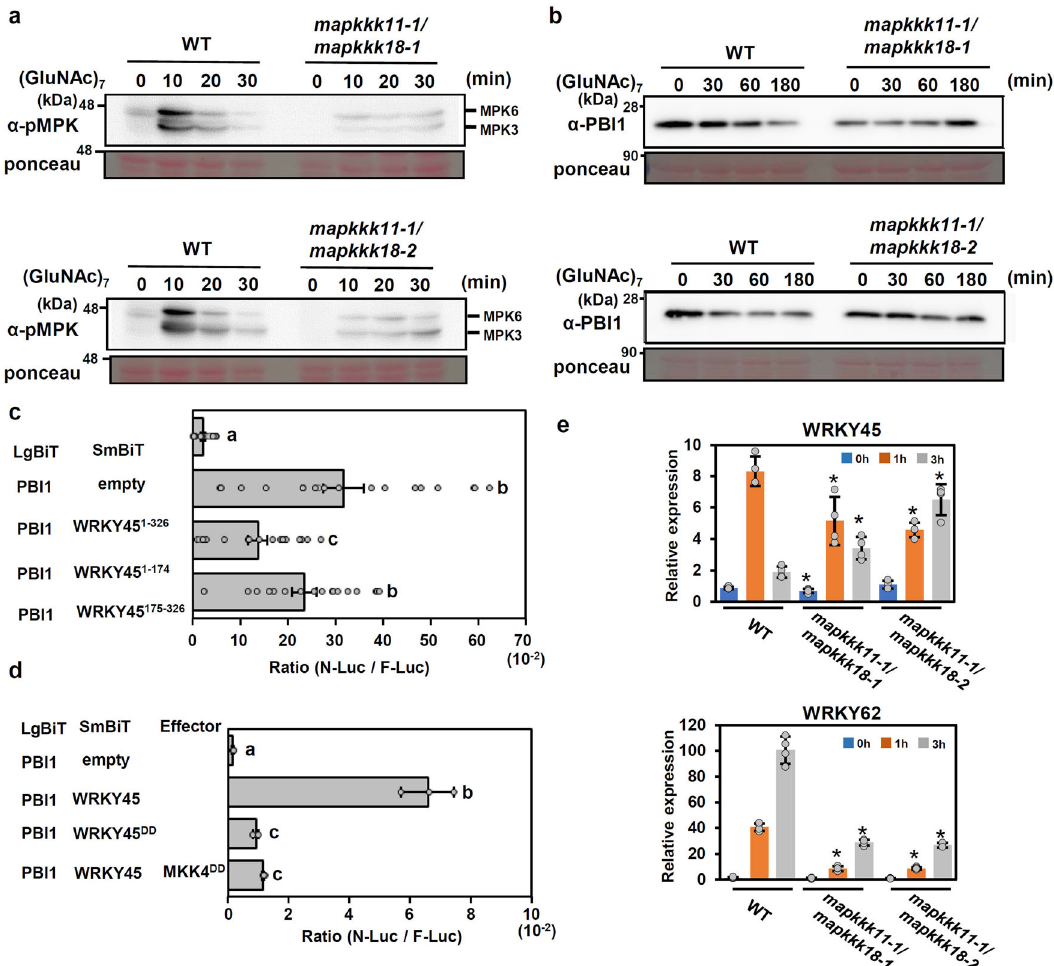
Fig. 6 MAPKs regulate PBI1 degradation. a Chitin-induced MAPK activation in two mapkkk11 / mapkkk18 mutants. Total proteins were prepared from rice suspension-cultured cells after treatment with 2 μ g/ml (GluNAc) 7 and subjected to immunoblots with α -pMAPK. b Chitin-induced PBI1 degradation was inhibited in the mapkkk11 / mapkkk18 mutants. Total proteins were prepared as for ( a ) and probed with α -PBI1. c The interactions between PBI1 and full length WRKY45 or WRKY45 fragments were analyzed using split NanoLuc luciferase assays. PBI1 was fused to LgBiT, and the WRKY45 fragments were fused to SmBiT. F-Luc was used as an internal control. Rice protoplasts were transfected with the constructs and the interactions were indicated by the N-Luc to F-Luc ratios. Data are means ± SE. n = 19 biologically independent replicates. Different letters above the data points indicate signi fi cant differences ( p < 0.01, two-sided Welch ’ s t test). d Phosphor-mimic mutation of WRKY45 reduces the interaction with PBI1. Split NanoLuc luciferase assays were carried out by transient expression of PBI1-LgBiT and WRKY45-SmBiT or WRKY45 DD -SmBiT with or without MKK4 DD in rice protoplasts. Values are means ± SE. n = 3 biologically independent replicates. Different letters above the data points indicate signi fi cant differences ( p < 0.01, two-sided Welch ’ s t test). e The expression levels of WRKY45 and WRKY62 in mapkkk11 / mapkkk18 suspension-cultured cells treated with 2 μ g/ml (GluNAc) 7 were analyzed using quantitative real-time PCR. Data are means± SD. n = 4 biologically independent replicates. The asterisks indicate statistically signi fi cant differences from the WT controls by two-sided Student ’ s t -test ( P < 0.05). All above experiments were repeated three times with similar